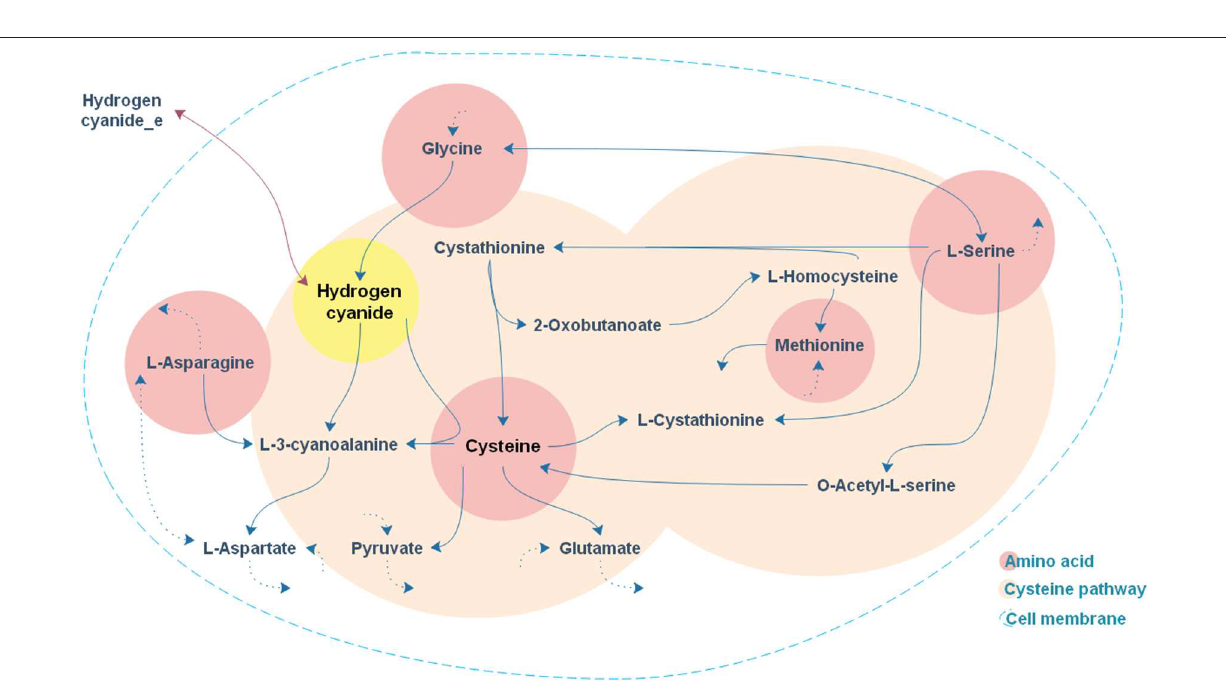
Figures 5B–D , the maximum biomass yield is smaller than that in Figure 5A , with a reduction of 30–50% due to withdrawing the cut sets from the network. This means that finding